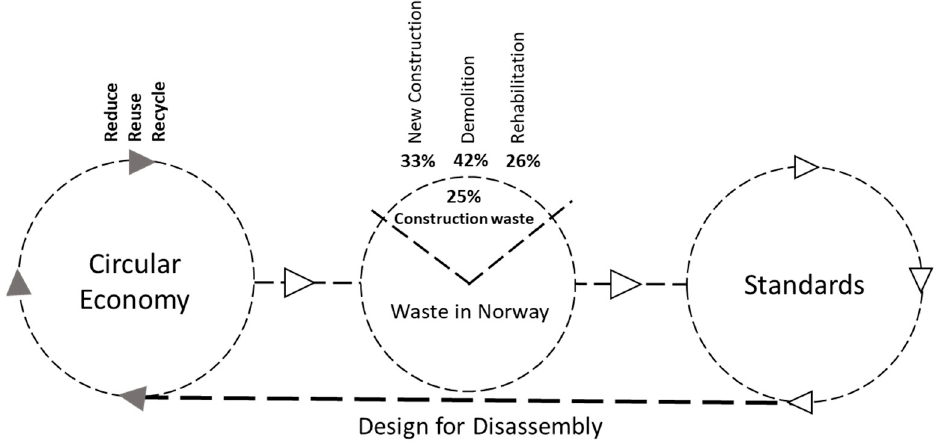
Figure 1. Implementing circular economy strategies in the building sector by means of standards.